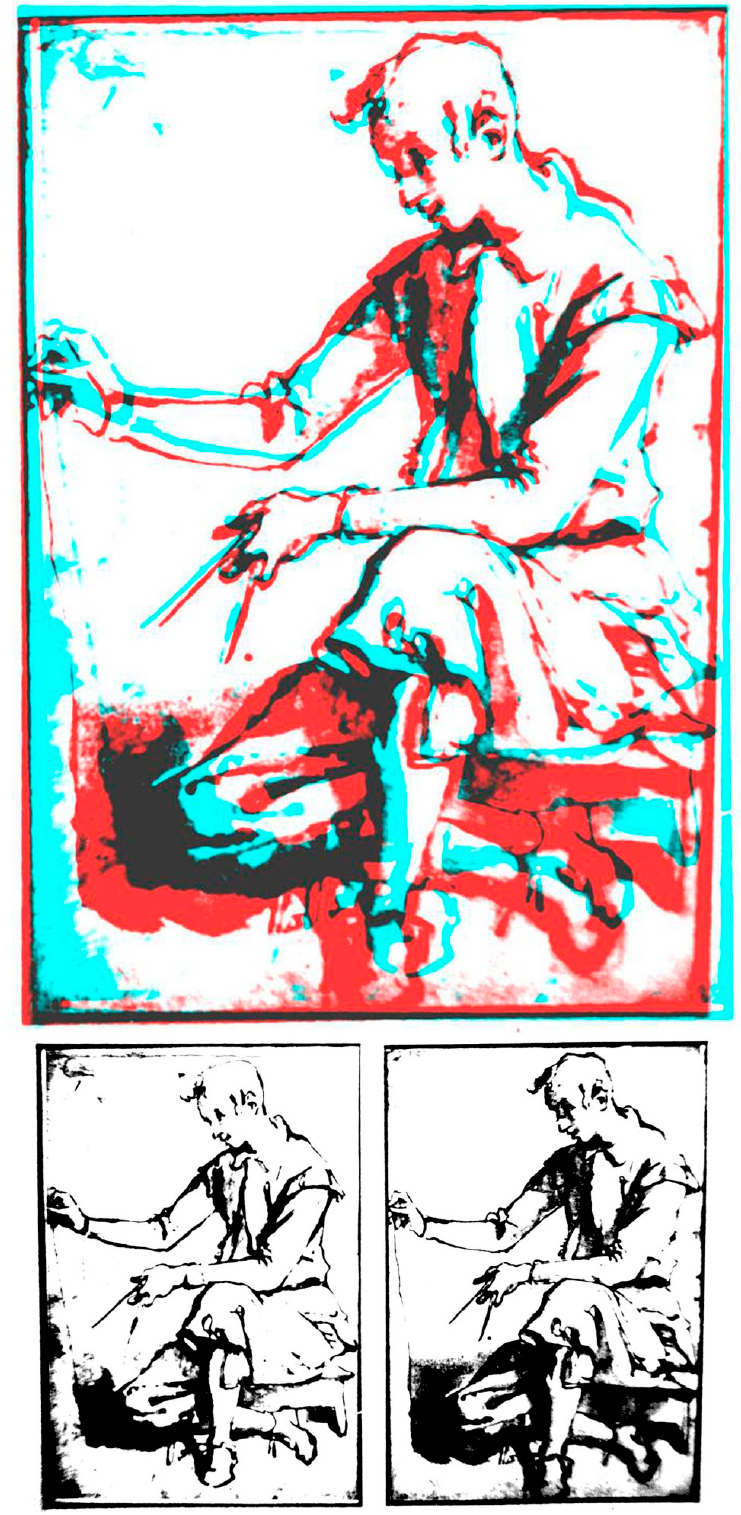
Figure 6. The Chimenti drawings derived from photographs taken by Arthur Gill. It is not clear whether there was a left and right image and so they are not presented in Universal Freeview format.